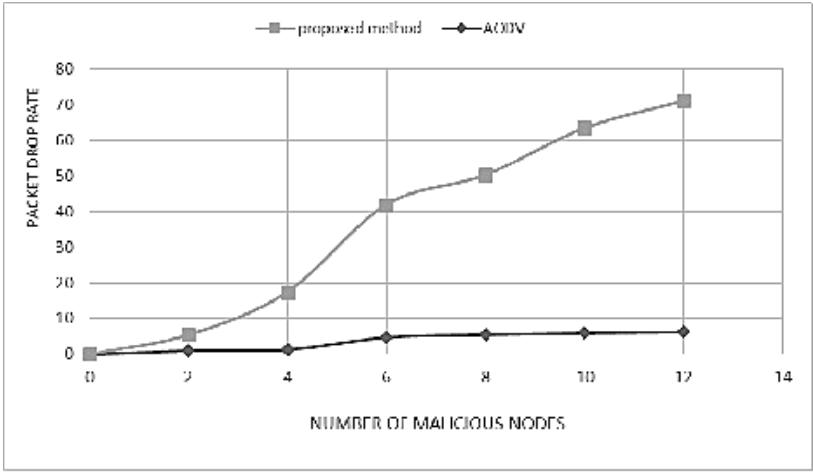
Figure 2. Packet drop rate vs. number of malicious nodes.